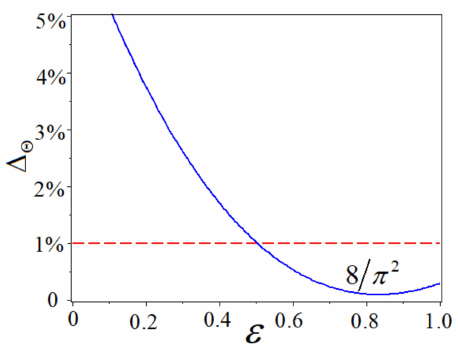
Figure 5. Relative errors curve ∆ Θ − ε of original Equation (47) when α = 2.0, ћ = − 0.45.